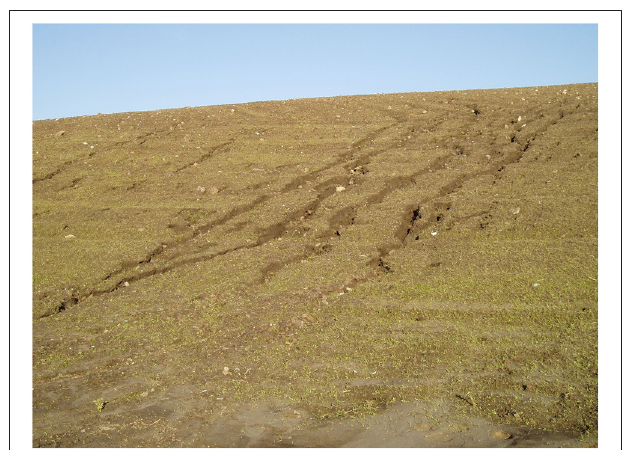
FIGURE 7 | Example of soil erosion on an agricultural field, showing midslope erosional gullies and soil deposition at the footslope (bottom of the image).